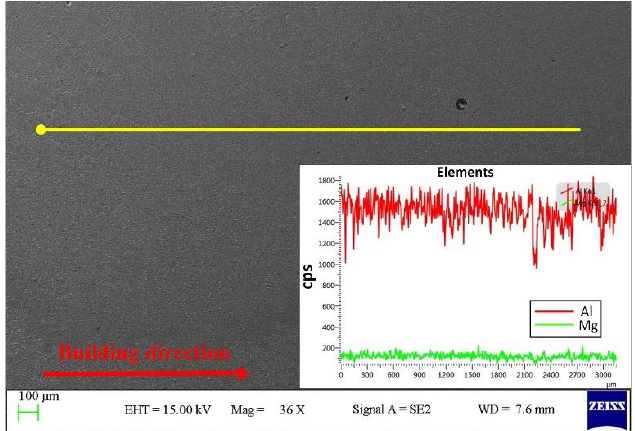
Figure 15. EDS linear scanning through layers with length of 3 mm.